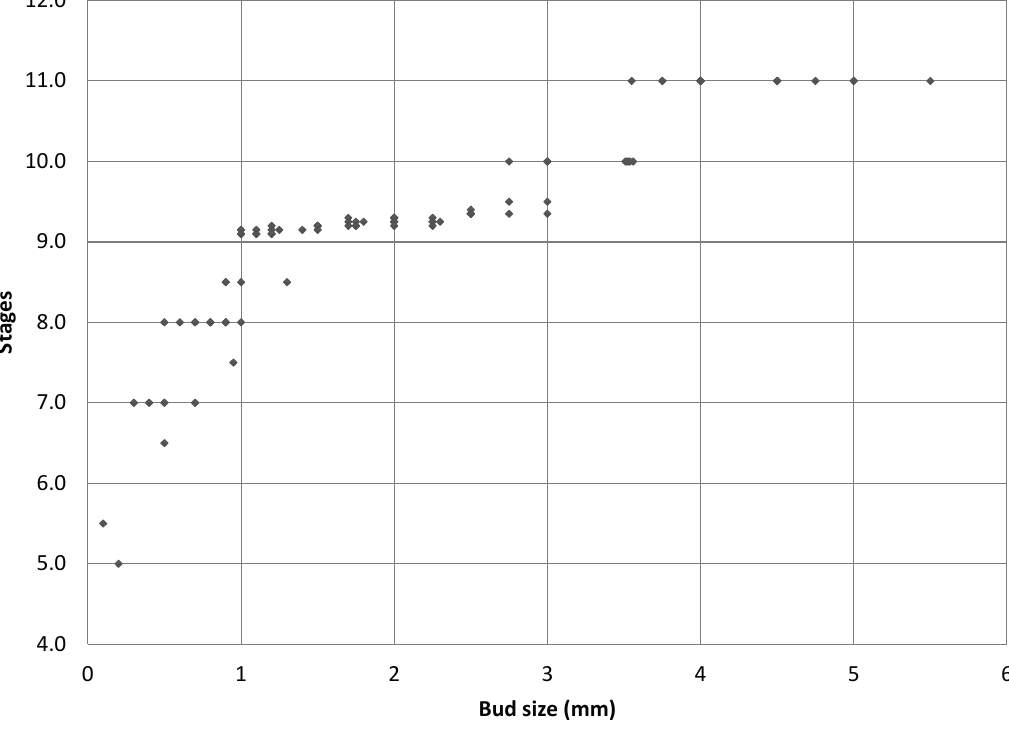
Figure 6. Scatterplot of male infected bud floral stage against the size of the floral buds.